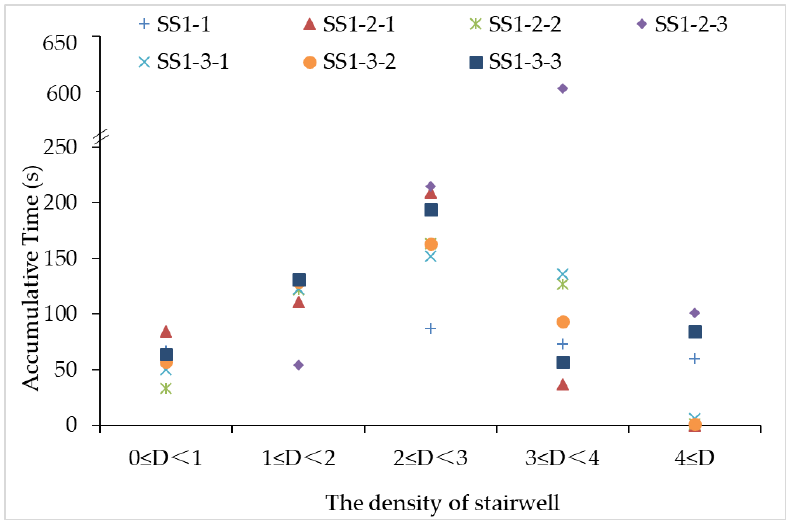
Figure 5. The accumulative time of different densities of the stairwell between the 1st and 2nd floor.